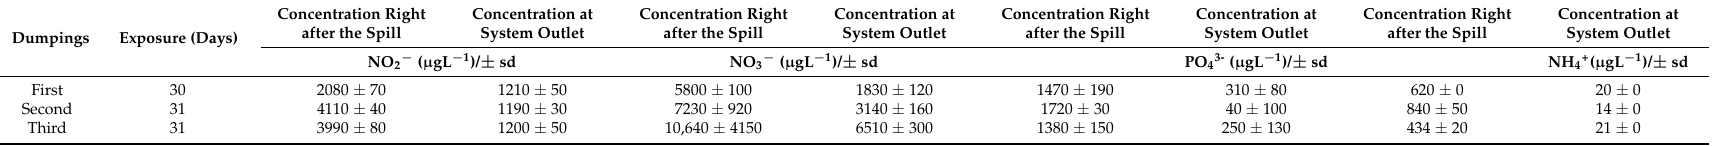
Concentration Right after the Spill